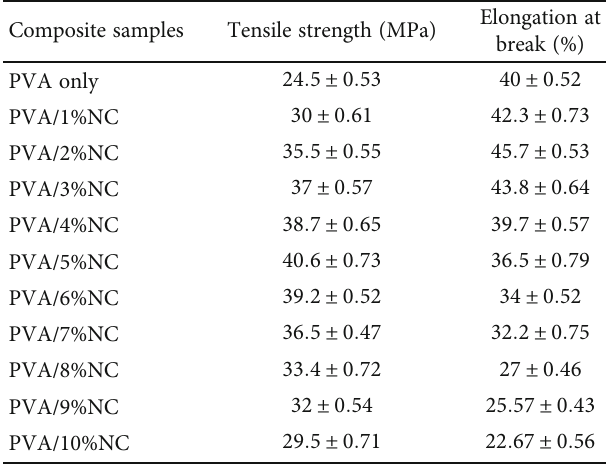
Table 1: Tensile strength and elongation at break of neat PVA and composite fi lms with di ff erent NC loading.